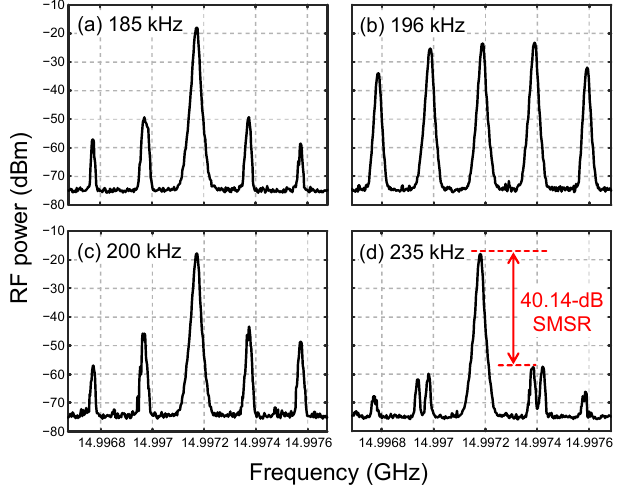
Figure 4. Measured electrical spectrum of the OEO by various RF modulation frequencies. ( a ) Electrical spectrum at 185 kHz modulation frequency. ( b ) Electrical spectrum at 196 kHz modulation frequency. ( c ) Electrical spectrum at 200 kHz modulation frequency. ( d ) Electrical spectrum at 235 kHz modulation frequency.